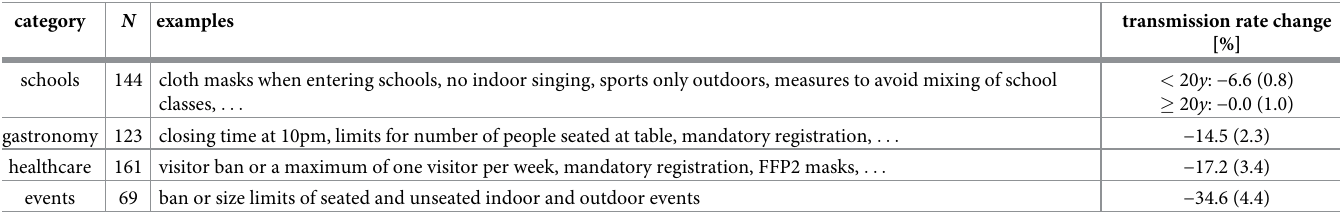
Table 2. Summary of effects of NPIs on the transmission rate. For each category of NPIs we give the number of implementations observed in our data, list typical exam- ples of what the NPI consists of and the percent change of the transmission rate associated with a unit SD change in the input.